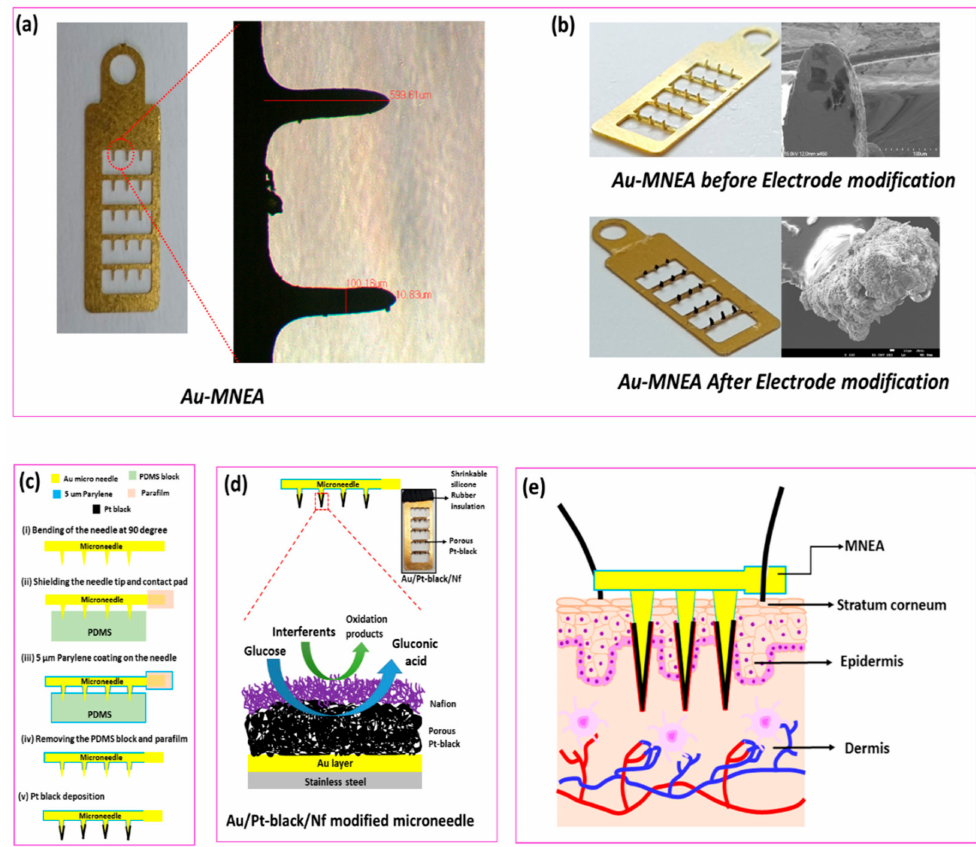
Figure 1. Optical micrographs of bare Au-modified microneedle electrode array (MNEA) showing a length of 599.61 µ m and width of 100.16 µ M ( a ). Optical and SEM Micrographs of the fabricated MNEAs before and after the catalytic Pt-black layer deposition ( b ). Schematic representation for the fabrication of MNEA ( c ) and mechanism of glucose oxidation on the surface of Pt-black modified MNEA ( d ). The schematic illustration of MNEA insertion into superficial dermis of rat skin ( e